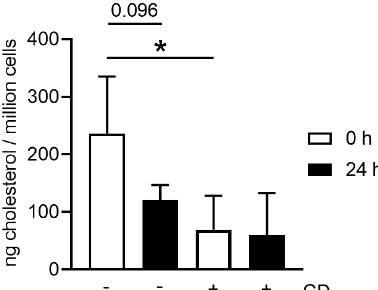
Figure 7. Neutrophils isolated from fresh blood contain more cholesterol than neutrophils isolated from stored blood. Methyl- β -cyclodextrin (CD) was used as control to reduce cholesterol content in the cells. A significant decrease in cholesterol after CD treatment was only detectable in neutrophils from fresh blood. Data were analyzed with one-tailed paired Student’s t -test ( n = 3) and presented as mean ± SD (* p < 0.05).